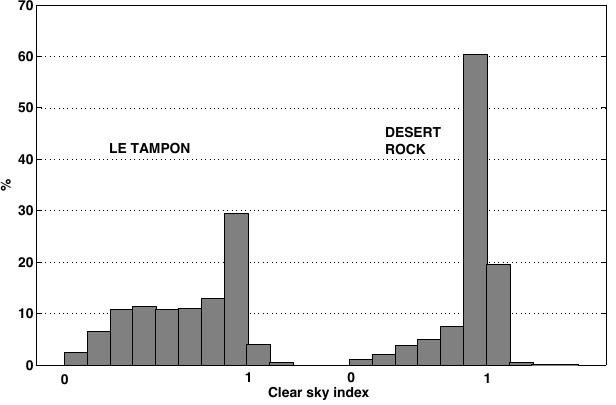
Figure 1. Statistical distribution of the 1-h clear sky index for the two locations under study, Le Tampon ( left ) and Desert Rock ( right